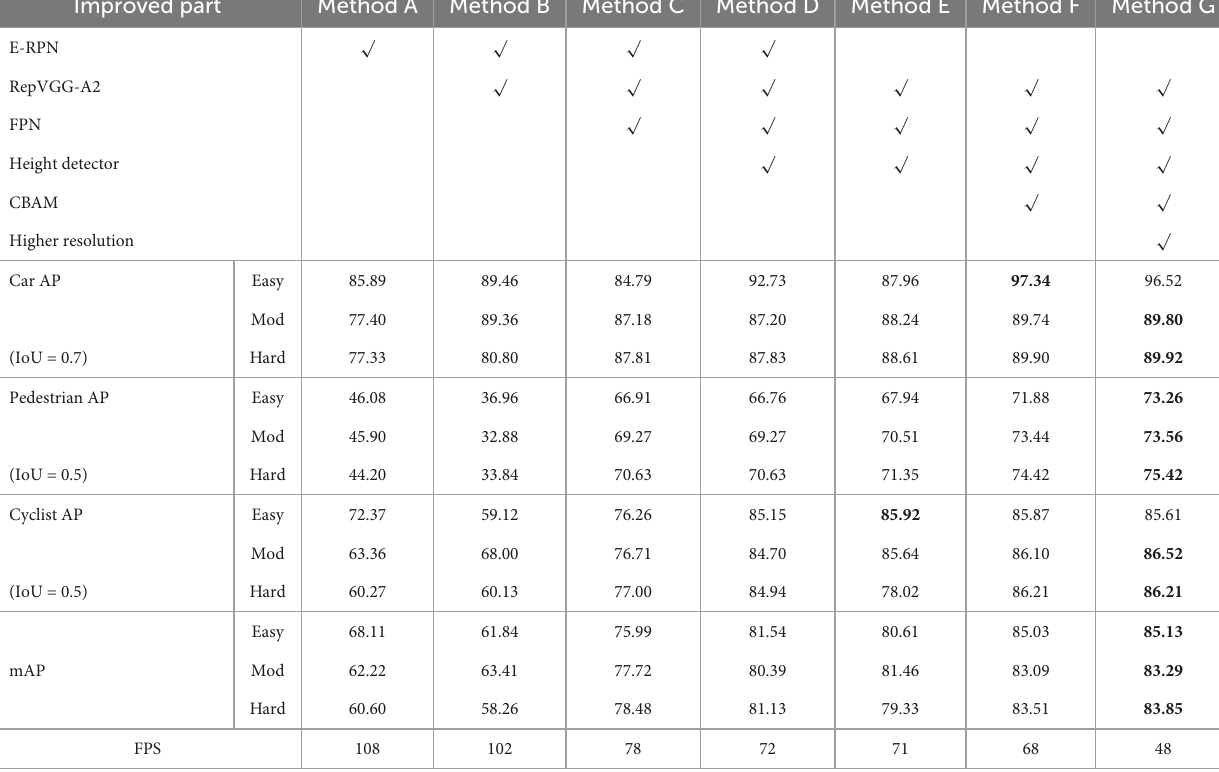
TABLE 2 Experimental results of the ablation experiments were used to verify the contribution of the improvements in this paper. Improved